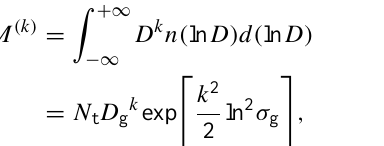
Fig. 2: Chemical composition of the modes in MADE and in MADE-IN. POM stands for particulate organic matter, BC for black carbon, DU for mineral dust and SS for sea salt. The externally mixed modes (aknext, accext) contain some amount of soluble material. When this amount is large enough the externally mixed modes are transferred to the internally mixed ones (aknmix, accmix).